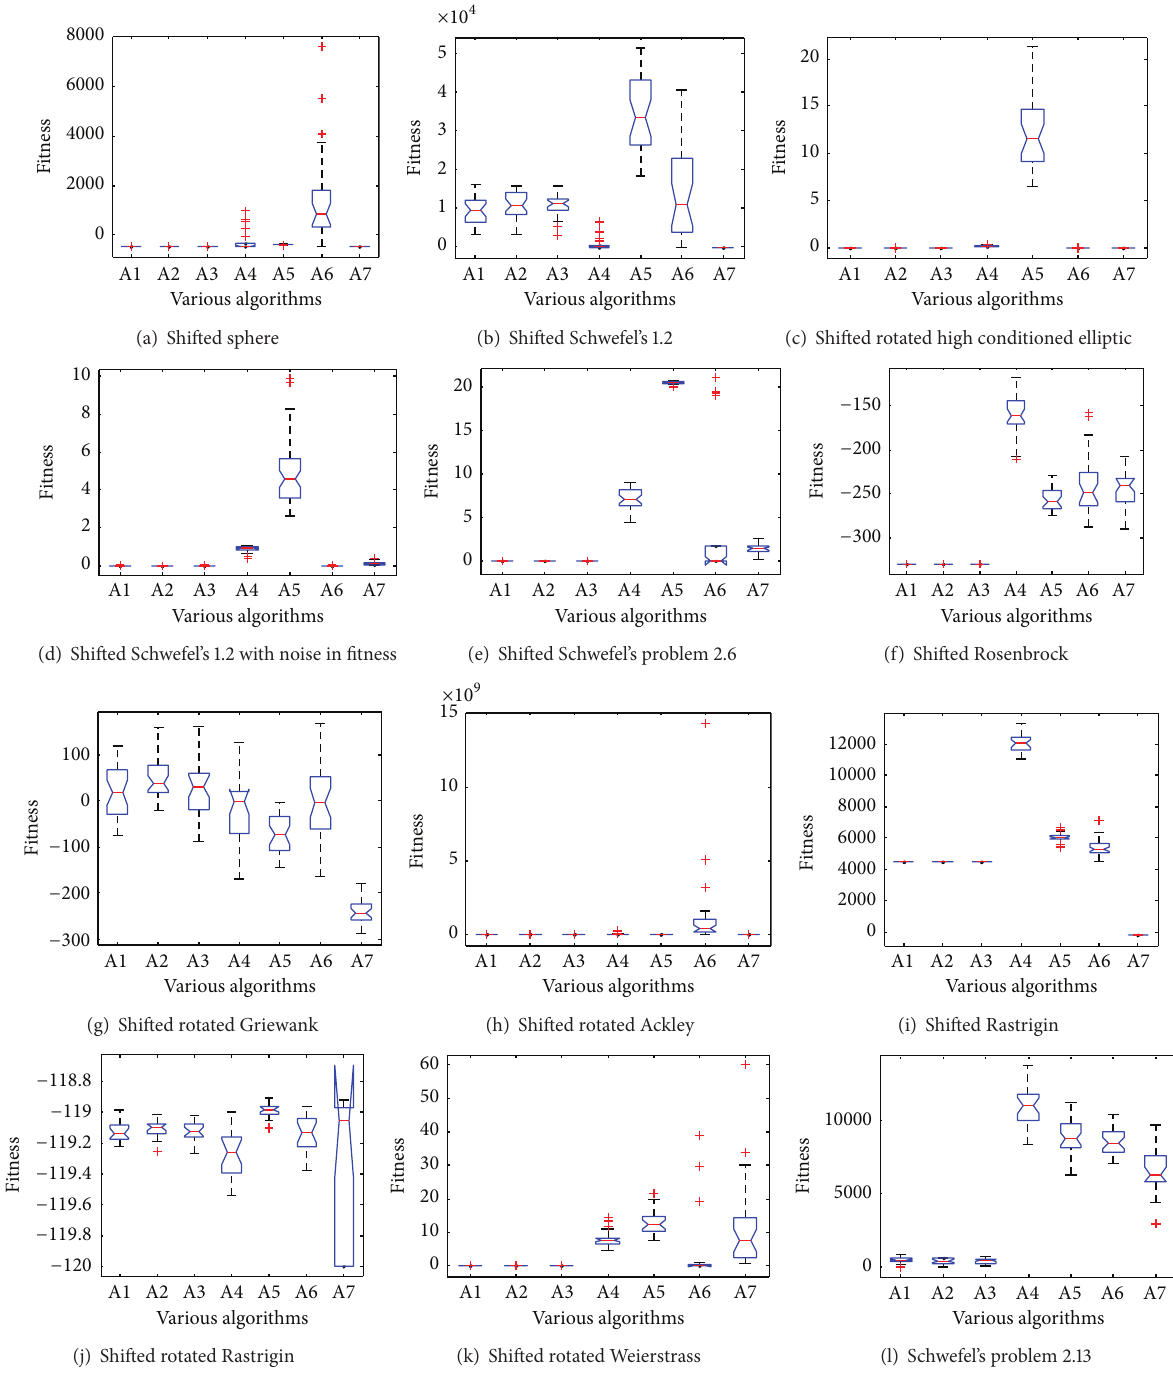
Figure 5: ANOVA results of all algorithms. Here, 1 to 7 are index of HABC, CABC, CPSO, CMA-ES, ABC, PSO, and GA, respectively.